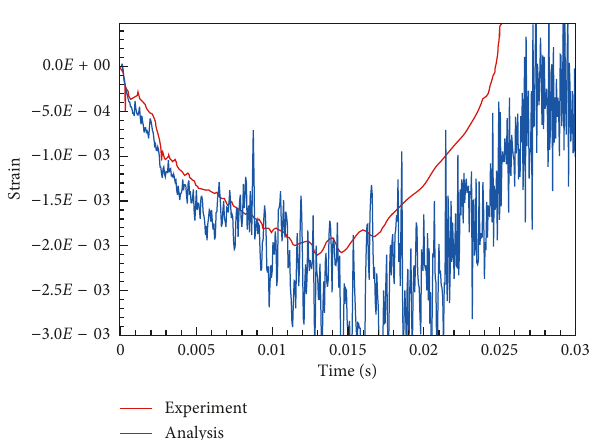
Figure 10: Strain at the front surface of the slab (strain gauge 2).